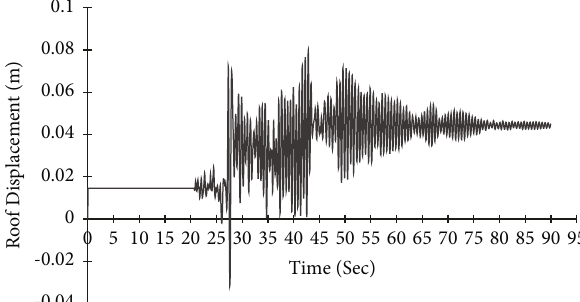
Figure 27: Displacement histories of the unbraced portal frame.